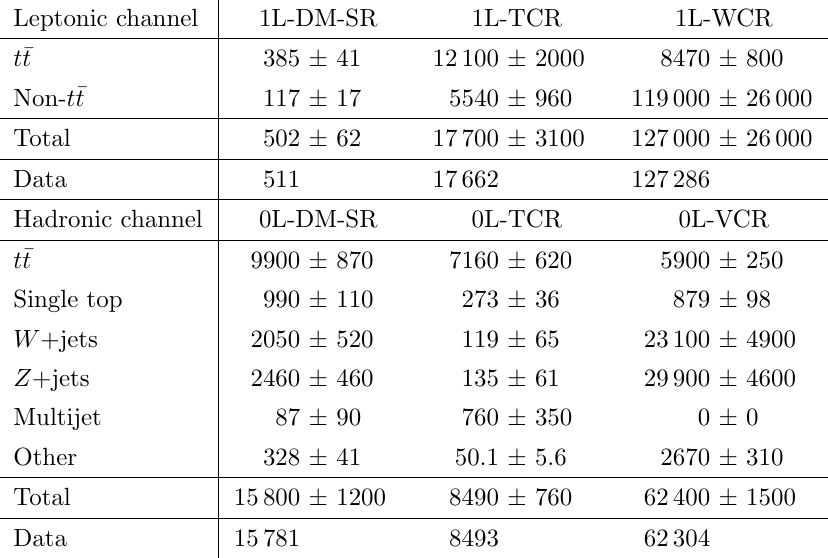
Table 5 . Numbers of events observed in the signal and control regions used for the non-resonant dark-matter search, together with the estimated SM backgrounds in the (cid:12)t to data, under the background-only hypothesis. The uncertainties include statistical and systematic